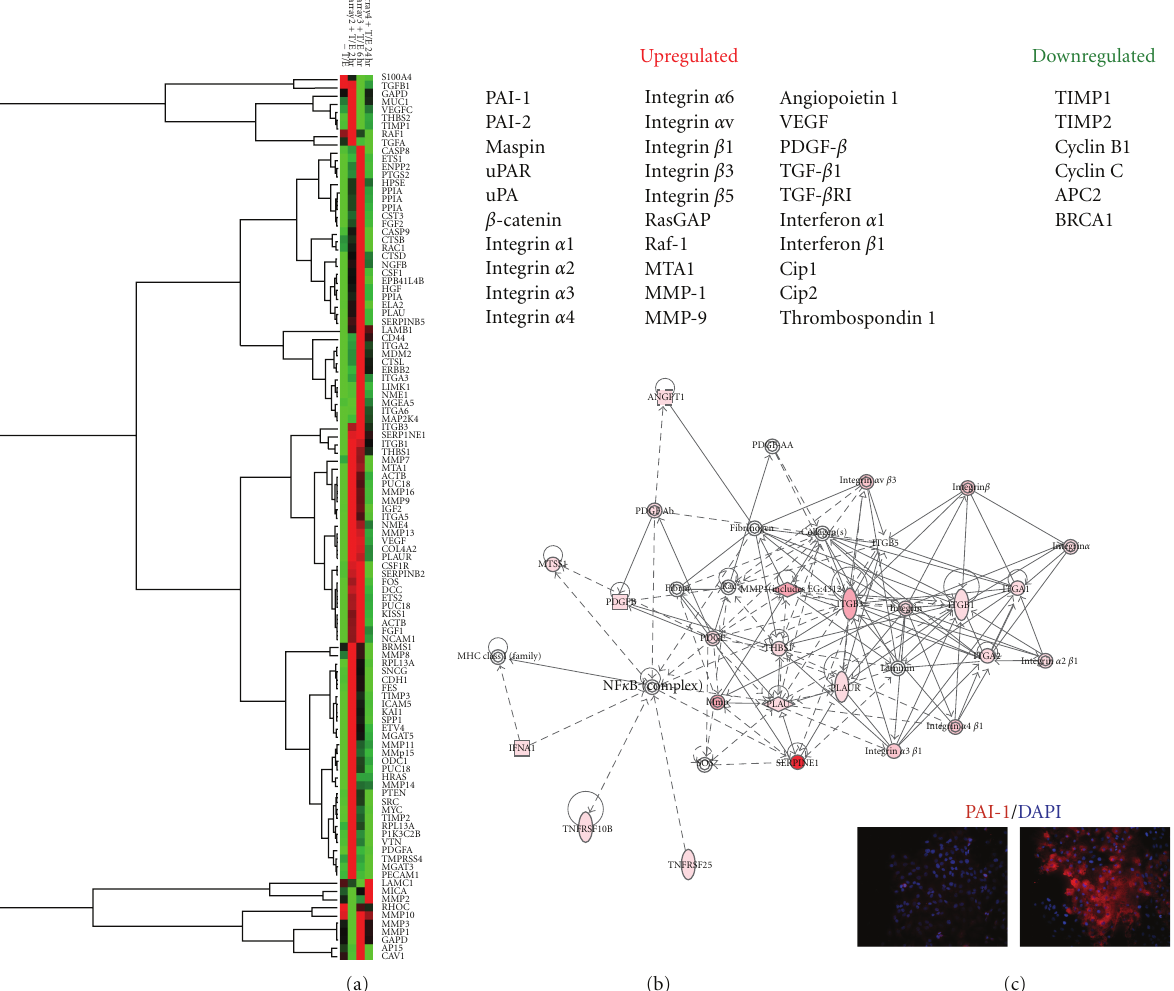
Figure 1: Transcriptome profiling and pathway analysis of the cellular plastic response upon combined exposure to transforming growth factor- β 1 (TGF- β 1) and epidermal growth factor (EGF). Microarray heat map of dual growth factor-stimulated HaCaT II-4 human keratinocytes illustrating the increased expression of mRNAs encoding proteins involved in the control of pericellular proteolysis, migration, and stromal invasion (a). PAI-1 transcripts were the most highly upregulated (170-fold), induced early (with 6 hours) after addition of TGF- β 1+EGF and prior to acquisition of the migratory phenotype. The Ingenuity pathway clustergram illustrates potential functional interactions among the repertoire of induced genes (b). Pathway analysis of many of the a ff ected genes (Table) indicate that several including uPA, uPAR, SERPINE1 (PAI-1), and MMPs are TGF- β 1 targets and encode critical elements in the integrative proteolytic cascades that regulate matrix remodeling and stromal invasion. Immunocytochemistry of paraformaldehyde-fixed, detergent-permeabilized, HaCaT II-4 cells that were serum-starved then stimulated with TGF- β 1+EGF for 5 hours indicated that increased PAI-1 mRNA abundance reflected an early up-regulation in immunocytochemically-detected PAI-1 protein (c). Left panel: unstimulated cells, right panel: TGF- β 1+EGF-stimulated keratinocytes. Nuclei were visualized with DAPI. c (cid:2) 2000–2009 Ingenuity Systems. Inc. All rights